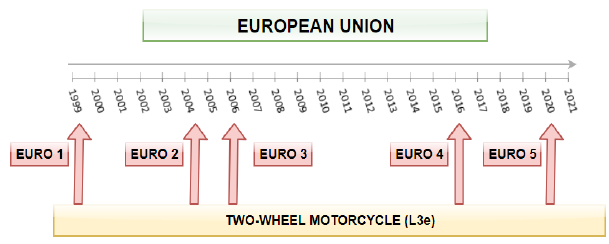
Fig. 2. History of exhaust emission standards for two-wheeled vehicles in Europe [10]